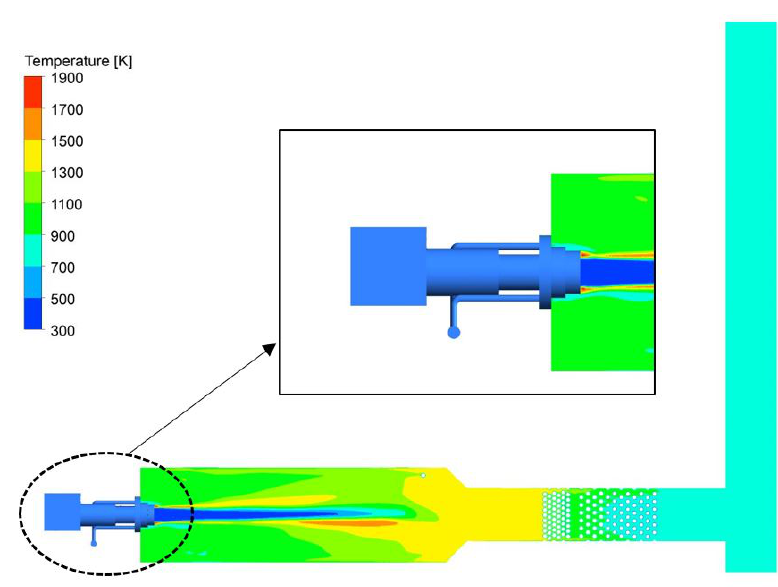
Figure 13. Temperature contour in a vertical cut in the middle of